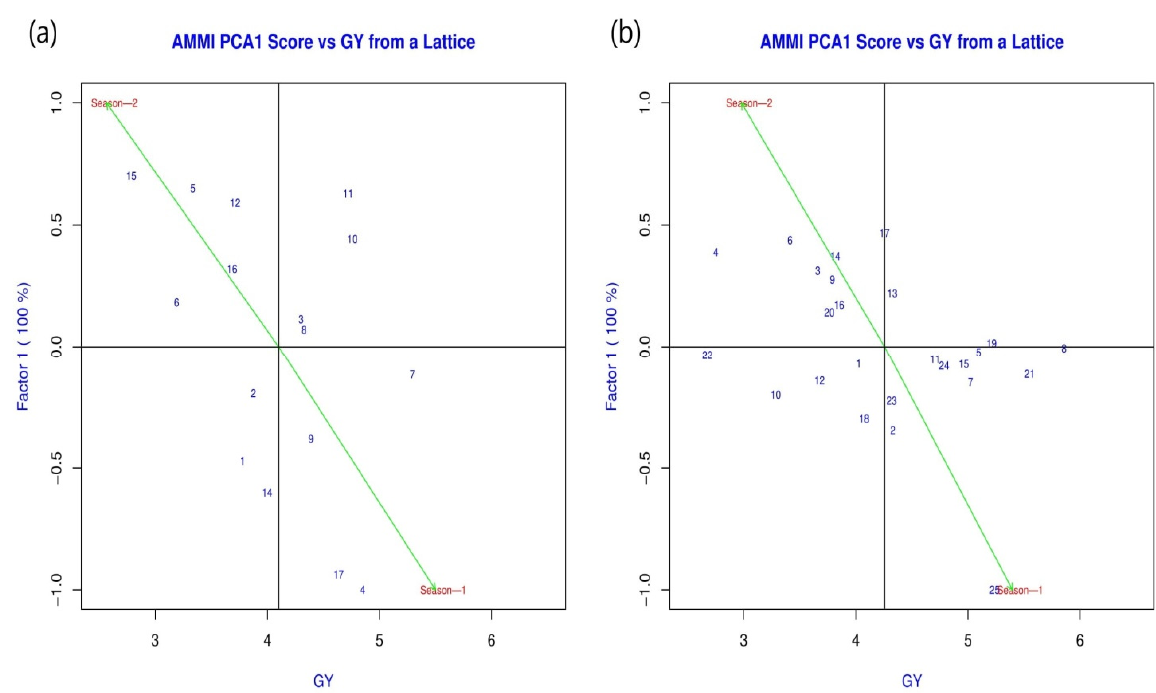
Figure 7. AMMI analysis of the grain yield trait of the maize genotypes from the two maize trials conducted under the contrasting seasons; figure ( a ) represents AMMI analysis of three way cross zinc biofortified hybrid maize genotypes, and figure ( b ) represents AMMI analysis of the regional extra early provitamin A biofortified hybrid maize genotypes, GY—grain yield (t ha − 1 ). The numerical value in the figure indicates respective entry numbers of the genotypes, the name of which can be retrieved from table 1.